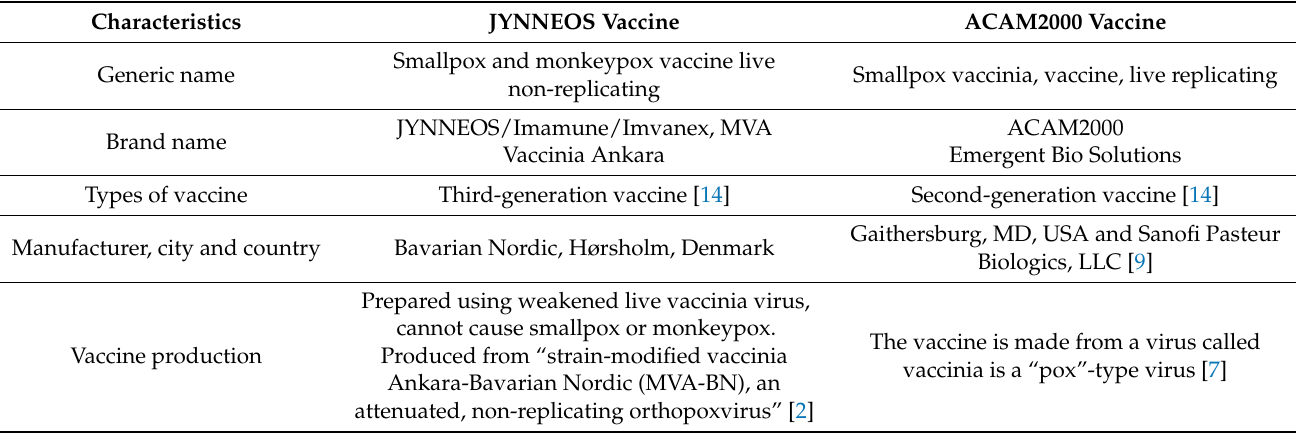
Table 1. Comparison between biological and pharmacological characteristics of JYNNEOS and ACAM2000 vaccines.